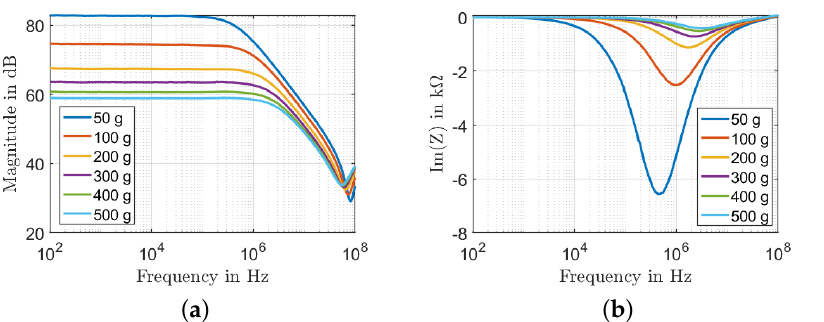
Figure 6. Influence of weights for sample 2: ( a ) Bode plot of the impedance magnitude; ( b ) imaginary part of the impedance as a function of